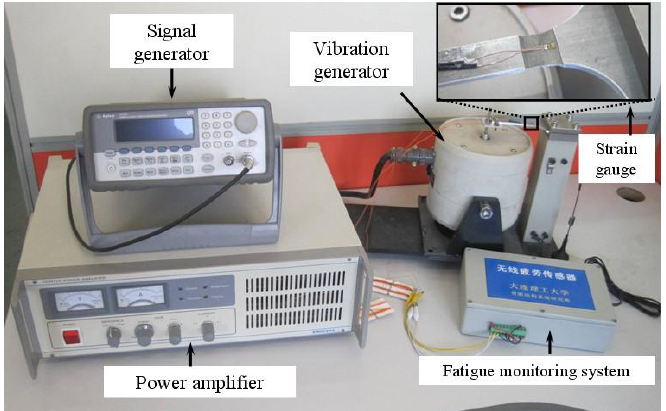
Figure 11. Experimental setup of fatigue test based on strain gauge.